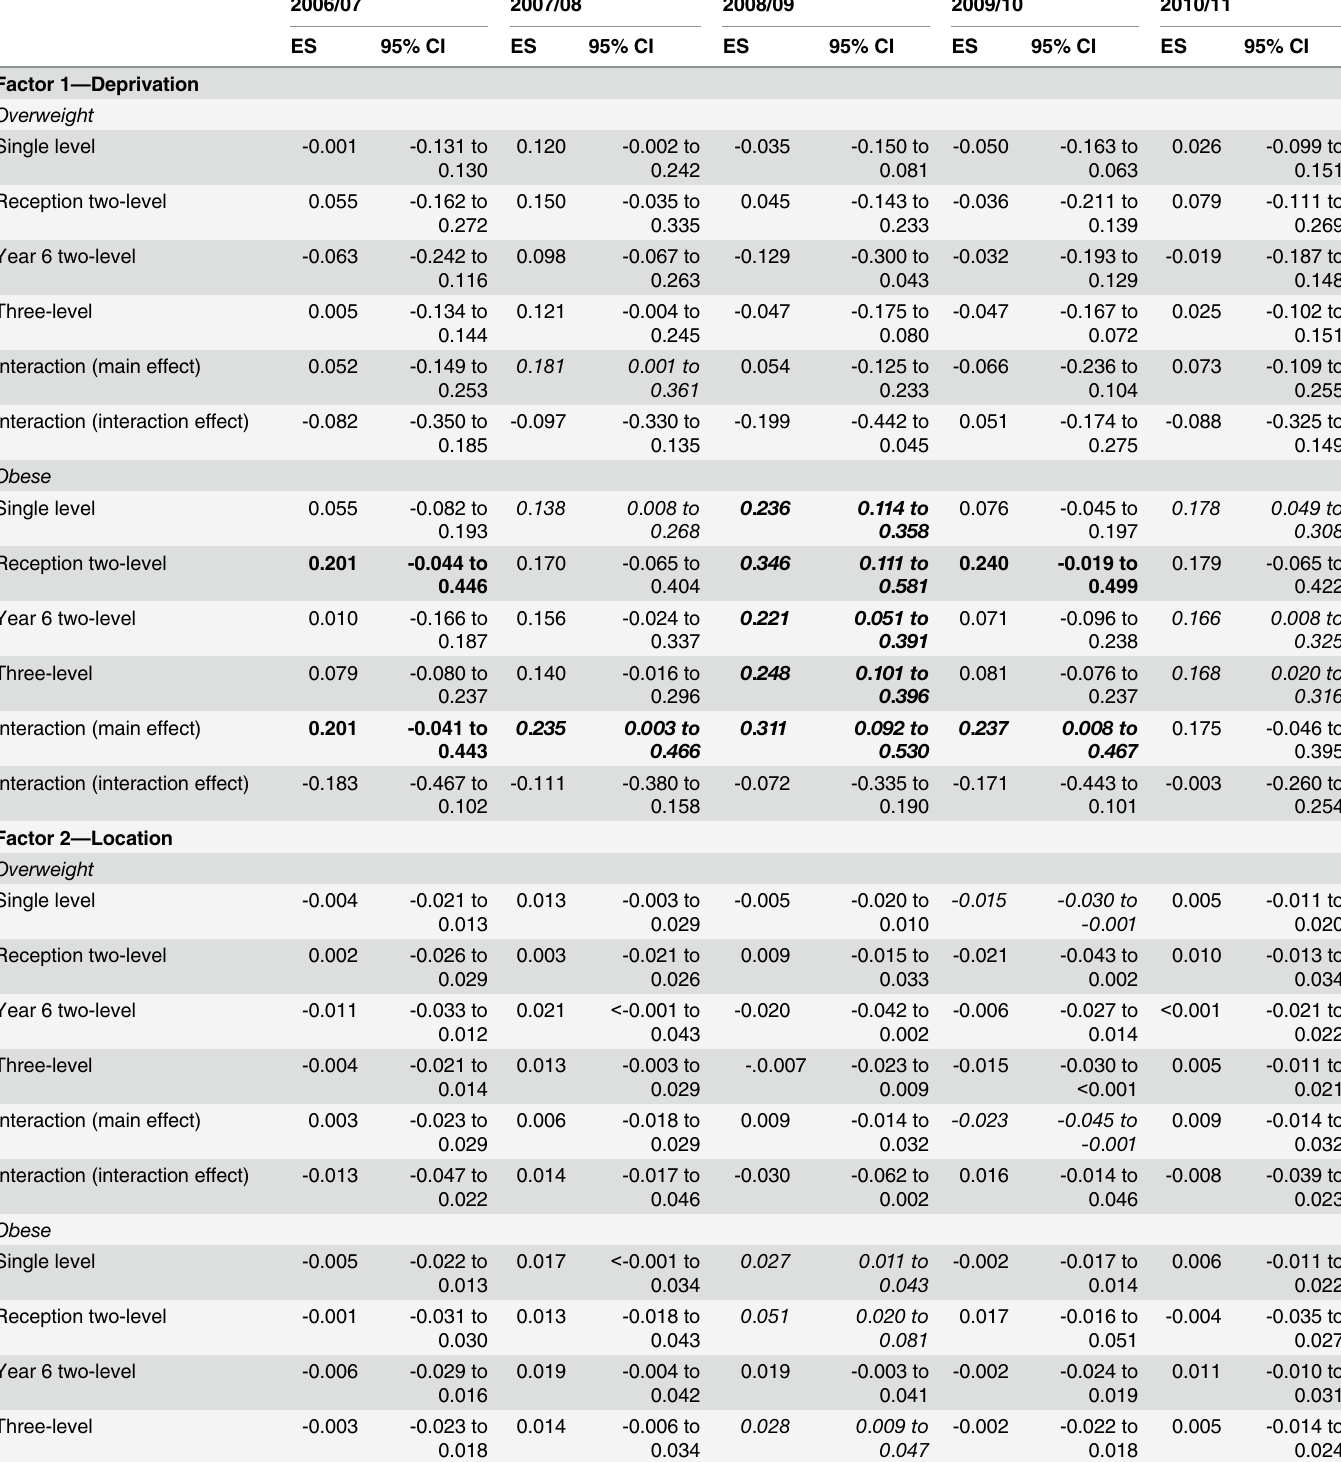
Table 5. Effect sizes